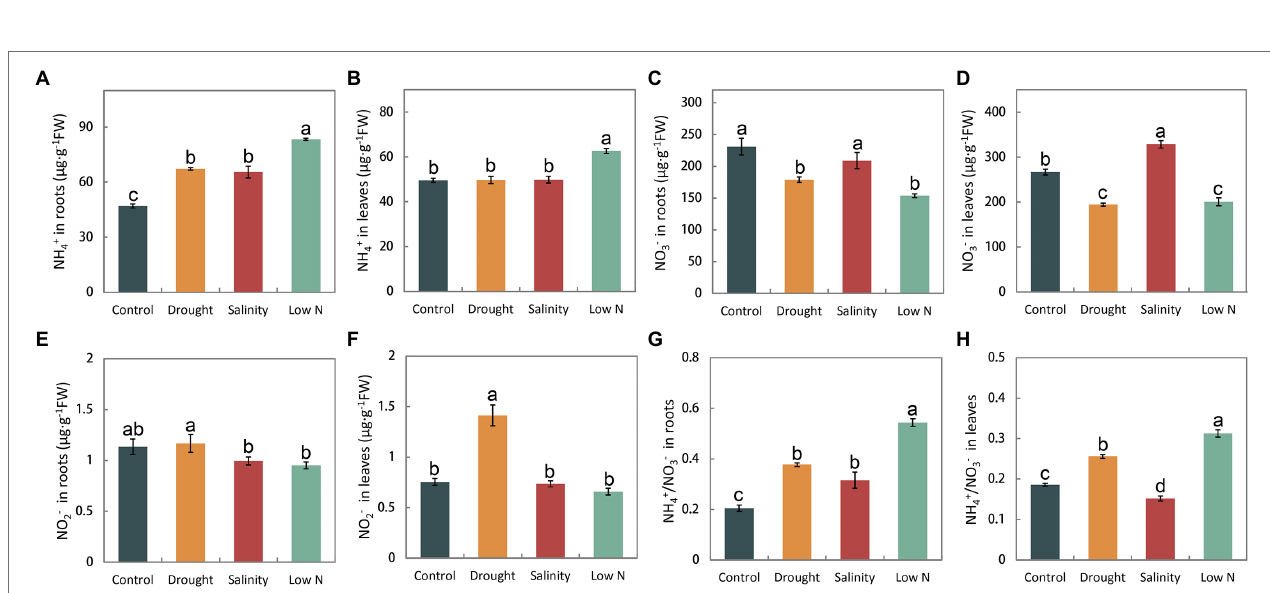
FIGURE 2 | Net photosynthetic rate (A) , chlorophyll content (B) , and total N concentrations in leaves (C) and roots (D) of S. japonica plants in response to drought, salinity, and low N treatment. Data indicate means ± SE of three replicates (12 plants). Bars labeled with different letters indicate significant differences between treatments ( p < 0.05).